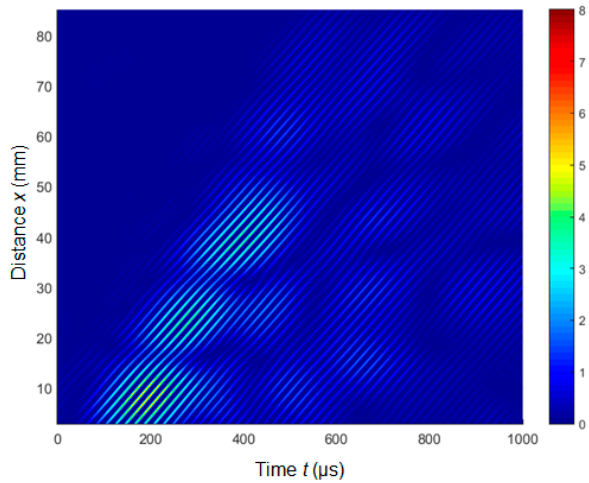
Figure 21. The B-scan obtained in the case of the contact excitation ( y = 0 mm).